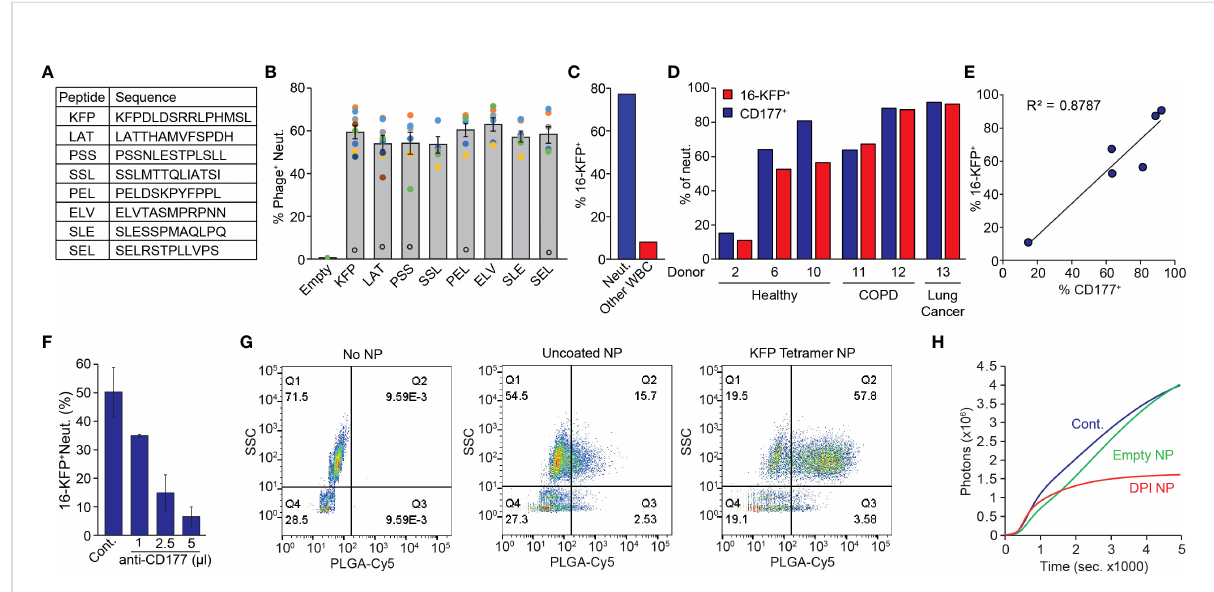
FIGURE 5 Characterization of Human P-NP. (A) High ranking human neutrophil binding peptide sequences. (B) Binding of phages expressing different peptides to CD66b + neutrophils from different donors (colored circles). Open black circles represent an outlier excluded from the overall average. (C) Representative quanti fi cation of 16-KFP binding to neutrophils (SSC high , blue) and other WBC (SSC low , red) from a healthy donor. (D) 16-KFP binding and CD177 expression of neutrophils of healthy donors (2, 6, 10), COPD patients (11, 12) and lung cancer patients (13). Note the low neutrophil binding and low CD177 expression in healthy donor #2. (E) Correlation between CD177 expression and 16-KFP binding in different donors. (F) Binding of 16-KFP to neutrophils with increasing amounts of CD177 blocking antibody. (G) FACS analysis of human neutrophil binding of KFP-tetramer coated (right) and uncoated (middle) PLGA-Cy5 labelled NP in WBC from a healthy donor. (H) PMA induced ROS production in control neutrophils (Cont.), neutrophils treated with empty (Empty NP) or DPI-containing P-NP (DPI